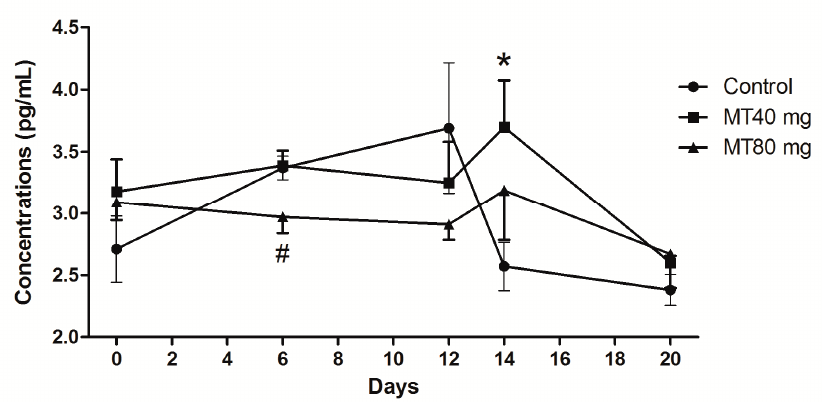
Figure 2. FSH concentrations throughout the study period. Day 0: CIDR insertion; Day 6: CIDR substitution; Day 12: CIDR removal; Day 14, insemination; Day 20: embryo recovery. During Days 12 to 14, the FSH concentrations in the control group dropped from their peak values to baseline levels; however, in the melatonin-treated deer, the FSH concentrations rose from their baseline levels to their peak values. These peak values were maintained only for a short time and decreased to their baseline levels again. Values are given as the mean ± S.E.M. The error bar is extended above and below at each time point in the MT40 mg group and MT80 mg group, respectively. “ * ” or “#” mean p < 0.05.